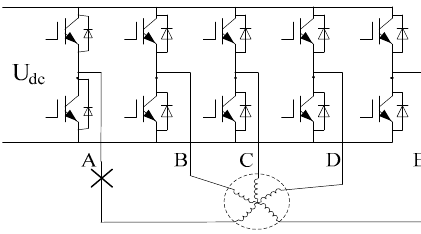
Figure 2. Single-phase open fault of FPMSM.